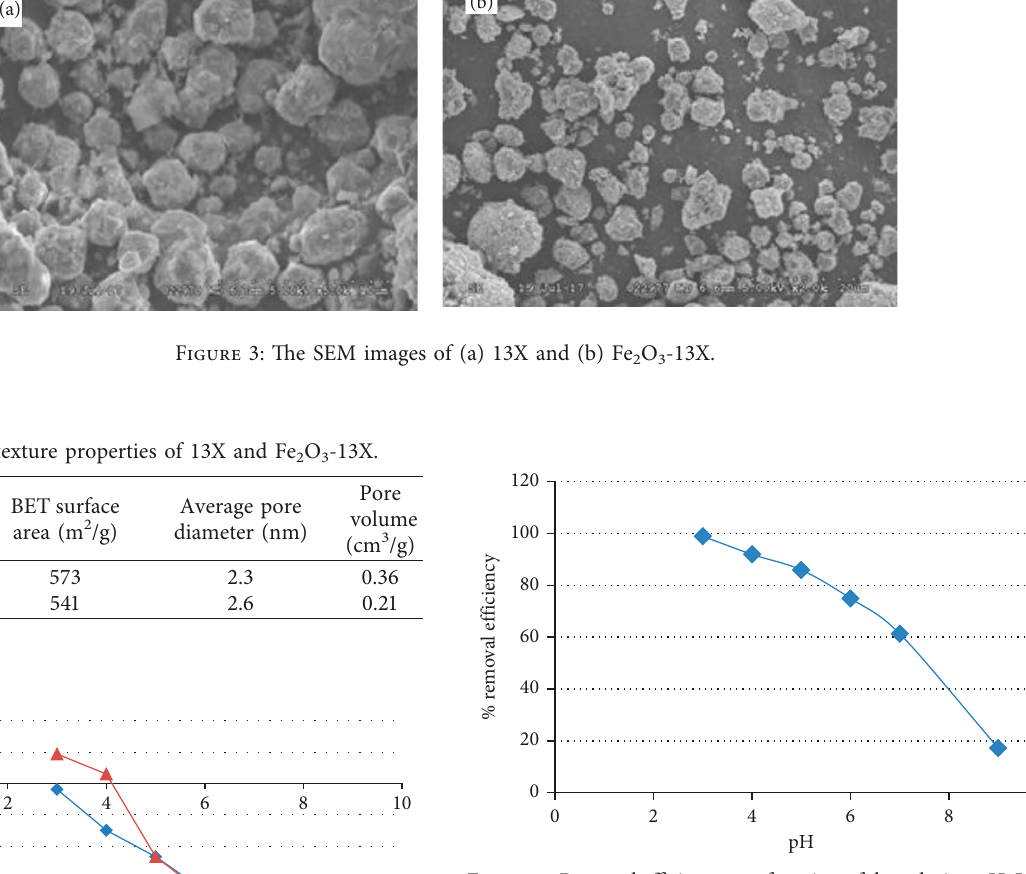
Figure 5: Removal efficiency as a function of the solution pH. Initial dye concentration 25mg/L, adsorbent dosage (cid:30) tion, and SDS amount 100mg/1L solution. (cid:30)